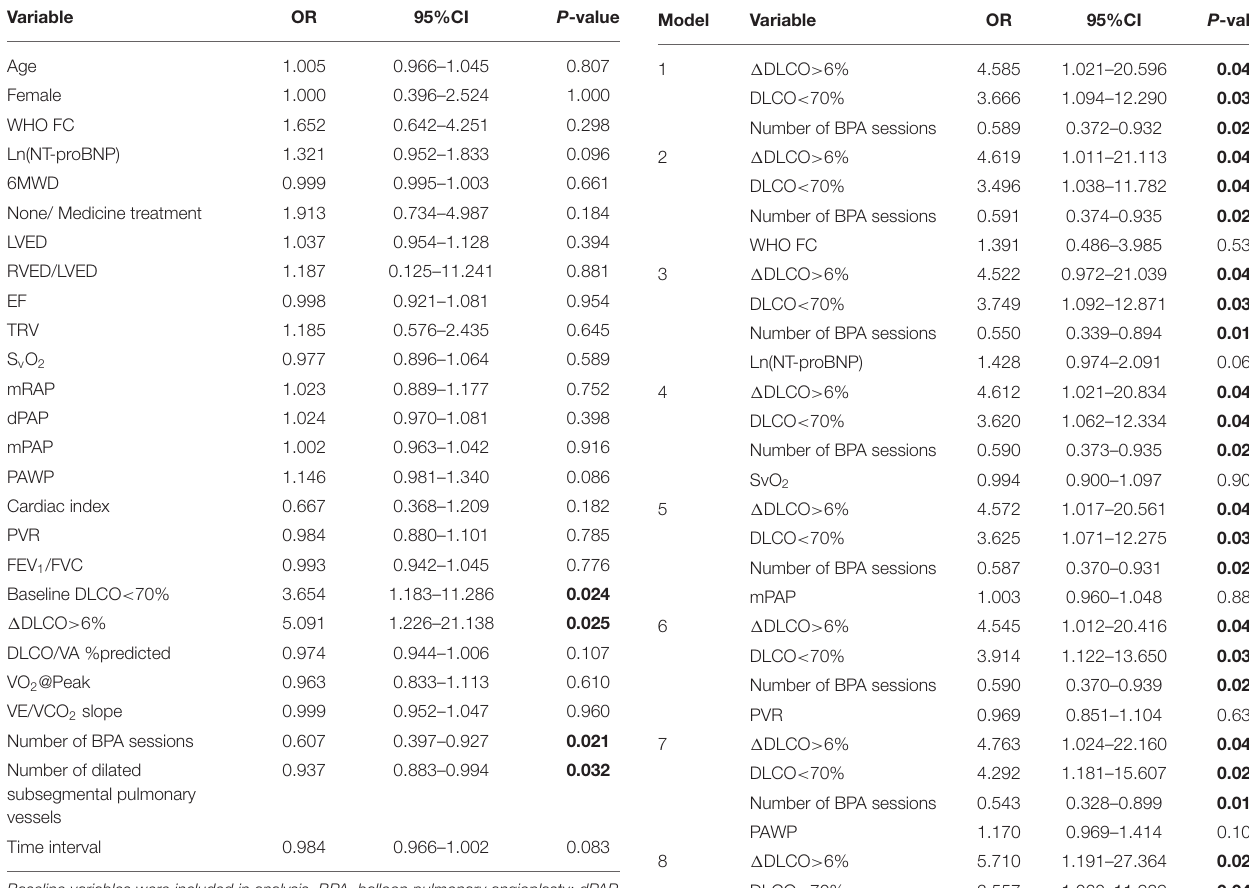
TABLE 5 | Multivariate logistic regression analyses for poor hemodynamic response to